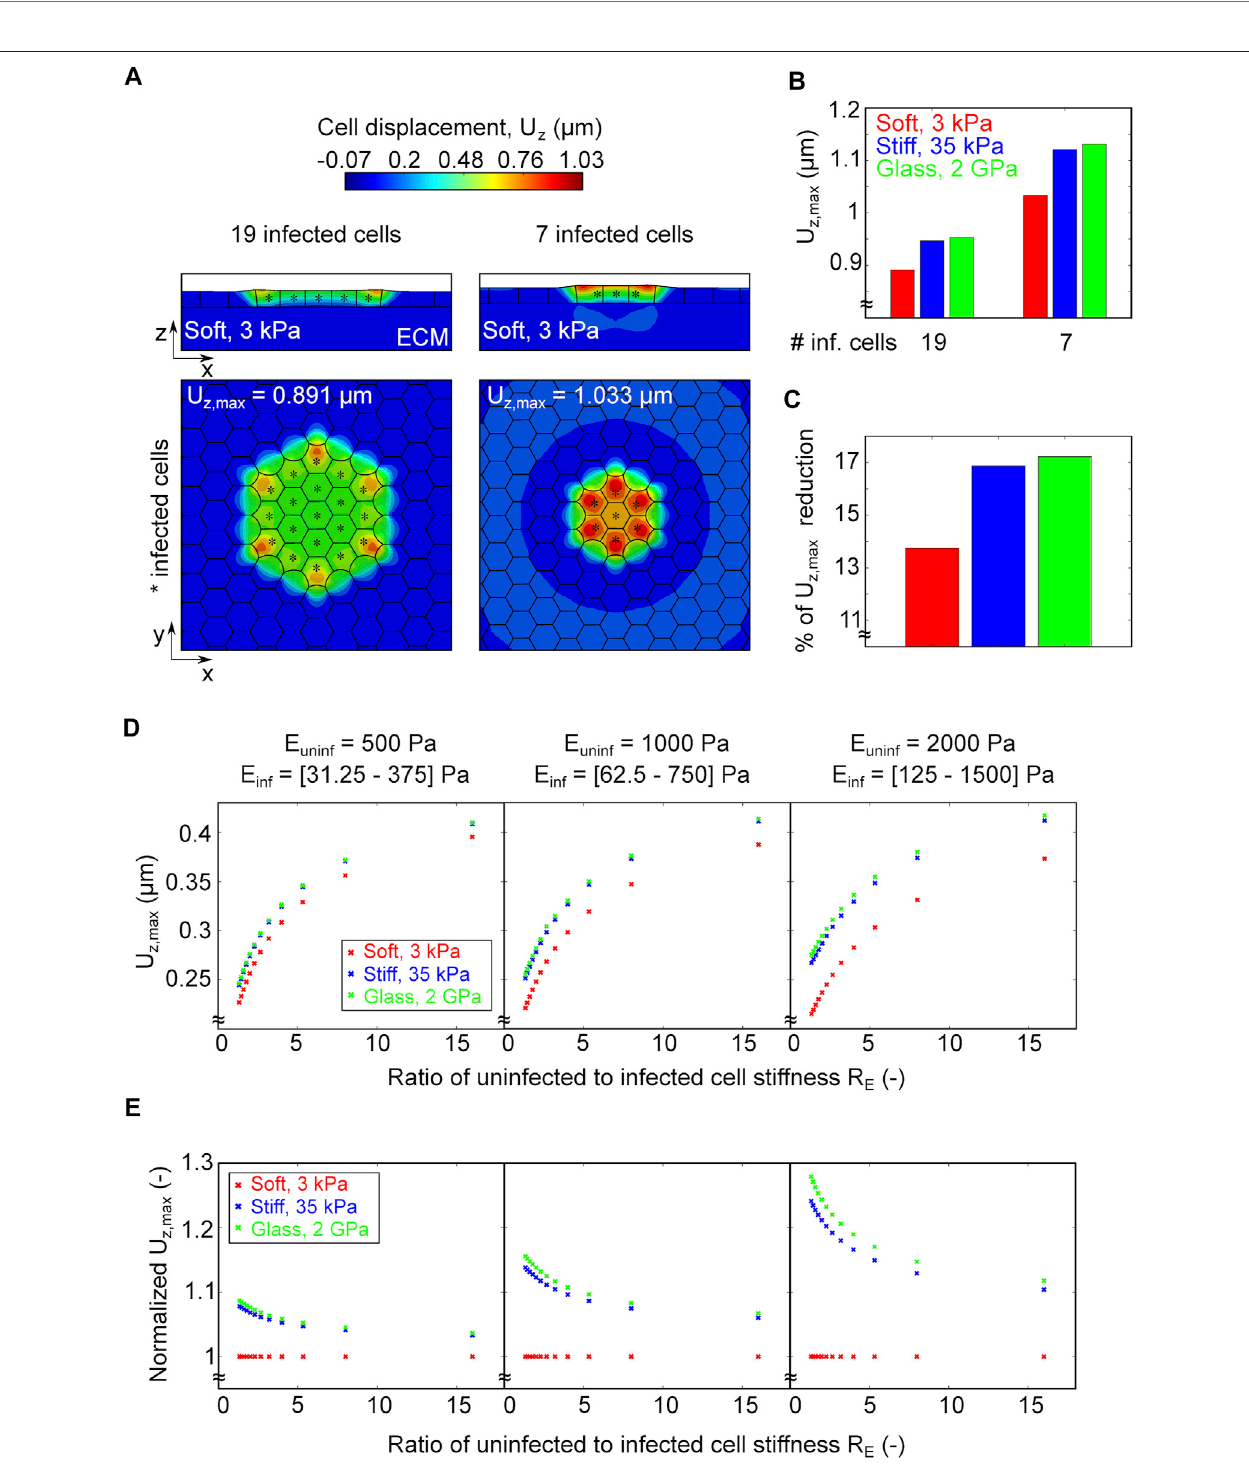
FIGURE 5 | A smaller infection focus or a larger difference in the ratio of uninfected to infected cell stiffness increase infected cell squeezing. (A) Ortoghonal view mapsofthemagnitudeofcellulardisplacementsintheverticalaxisU z ( μ m)of insilico infectedcellsresidingonasoft3 kPagel.Ontheleftpanelthefocusiscomprisedby 19infectedcellsdenotedbyasterisk,whereasontherightby7.Top(x – y)andside(x – z)viewsareshowninbothcases. (B) Barplotofthemaximumverticaldisplacement U z ,max of cells residing on soft (red), stiff (blue) and glass (green) matrices in the case of a focus comprised by 19 or 7 infected cells. (C) Barplot of the relative decreaseinU z ,max whencomparingfocicomprisedof7relativeto19infectedcellsforeachofthevaryingstiffnessmatricesindicatedinthepanelsabove. (D) Plotsofthe maximumverticaldisplacementU z ,max ( μ m,verticalaxis)versustheratioofuninfectedtoinfectedcellstiffness(R E ,horizontalaxis)for insilico infectionfocicomprisedof7 infected cells and cells reside on soft 3 kPa (red), stiff 35 kPa (blue) and 2 GPa glass (green) matrix. In the simulations we assumed that the stiffness of the uninfected surrounder cells was fi xed and equal to 500 Pa (left), or 1,000 Pa (middle), or 2,000 Pa (right), while infected cells could experience a range of stiffness shown below the plots (R E = 1 – 16). (E) Same as panel D but y -axis shows U z ,max normalized to U z ,max exhibited by cells on a soft 3 kPa matrix.